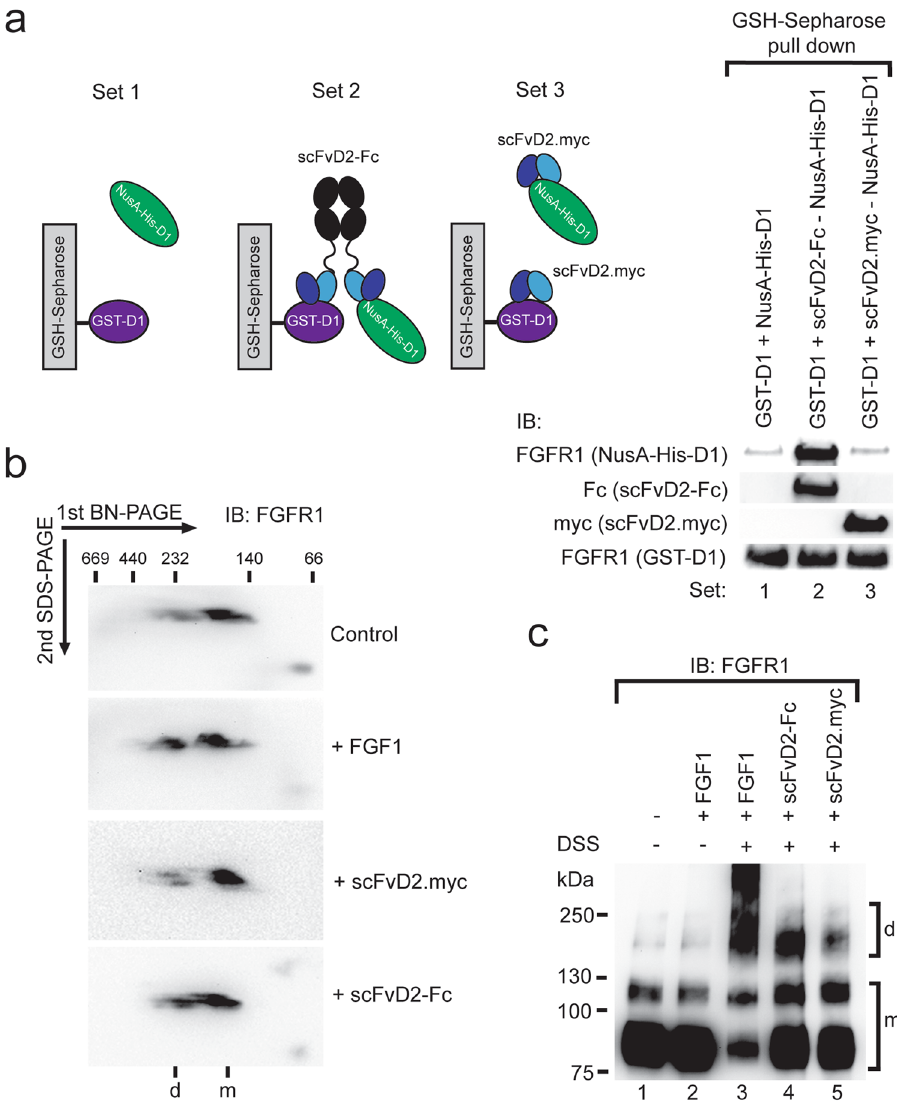
Figure 6. The bivalent scFvD2-Fc antibody fragment induce FGFR1 dimerization. ( a ) The bivalent scFvD2-Fc antibody can simultaneously bind two D1 domains of FGFR1. Purified his-tagged, NusA fusion of domain D1 of FGFR1 (NusA-His-D1) was incubated either alone or in the presence of the bivalent scFvD2-Fc or monovalent scFvD2.myc. Next, preformed antibody fragment-NusA-His-D1 complexes were incubated with purified GST fusion of D1 domain of FGFR1 (GST-D1). Proteins bound to the GST-D1 were analyzed by Western blotting using specific antibodies. The interaction of D1 domains with each other is strongly enhanced only in the presence of the bivalent scFvD2-Fc. ( b ) Oligomeric state of FGFR1 was studied with 2D BN/SDS PAGE. Serum starved NIH3T3 cells were treated with FGF1, scFvD2.myc or scFvD2-Fc. Membrane proteins were solubilized with digitonin and separated in the 1st native dimension using 4–13% BN-PAGE gels. Native gels were sliced and separated in the 2nd denaturing dimension using SDS-PAGE. Oligomeric state of FGFR1 was assessed by Western blotting using FGFR1-specific antibodies. ( c ) Chemical crosslinking reveals that the bivalent scFvD2-Fc antibody fragment can induce FGFR1 dimerization in cells. Serum starved NIH3T3 cells were incubated with FGF1, scFvD2.myc or scFvD2-Fc and crosslinked with DSS. Cells were lysed, FGFR1 was isolated by co-immunoprecipitation and oligomerization of FGFR1 was assessed by Western blotting using receptor-specific antibodies. Addition of FGF1 strongly induces FGFR1 dimerization. The bivalent scFvD2-Fc also induces FGFR1 dimerization, but to the lower extent than FGF1. In contrast the monovalent scFvD2.myc has no impact on the oligomeric state of